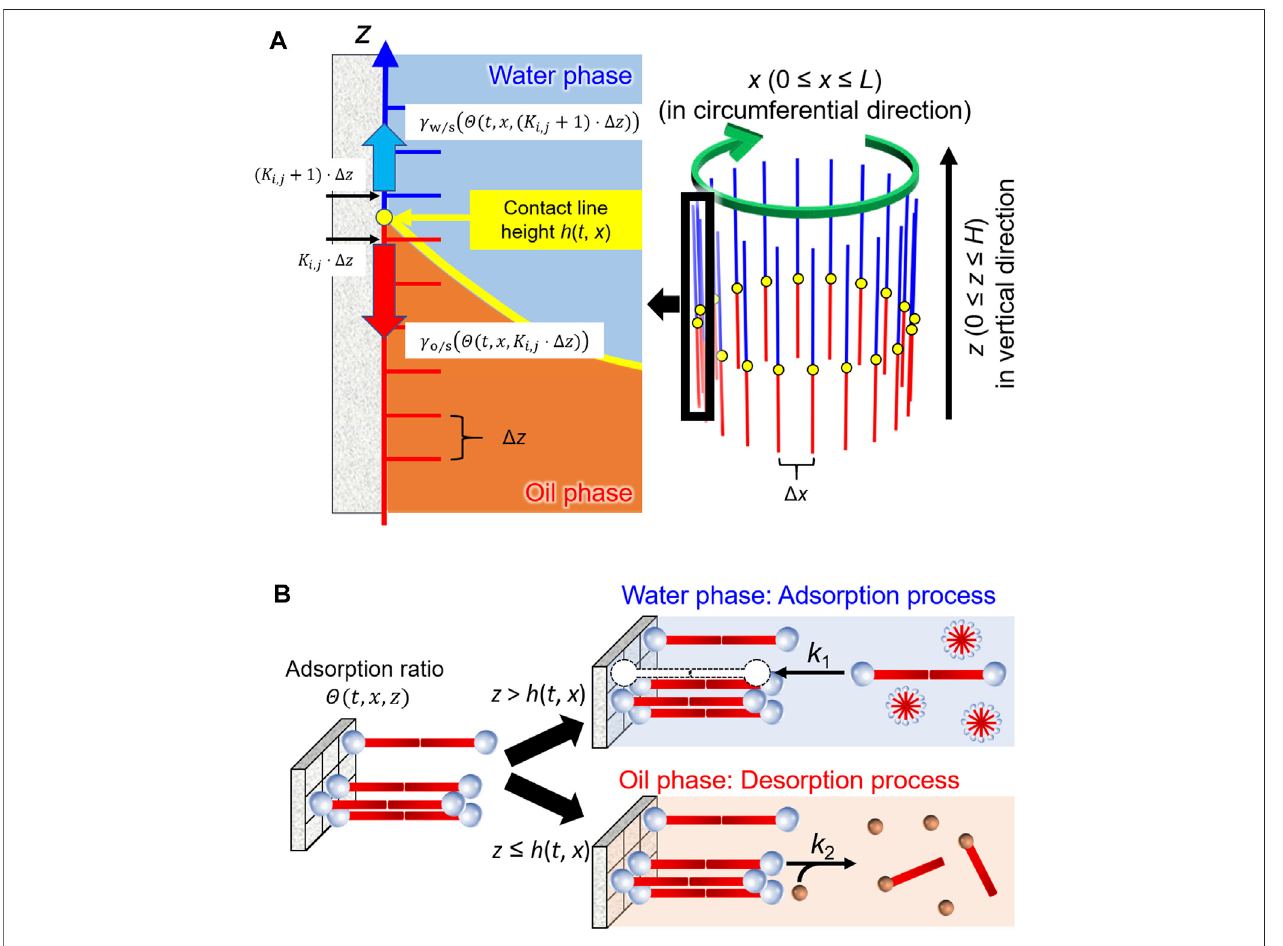
FIGURE 4 | Schematic illustrations of the model for (A) the contact line motion along inner wall of a glass tube and (B) adsorption/desorption processes of the surfactants in water and oil phases.